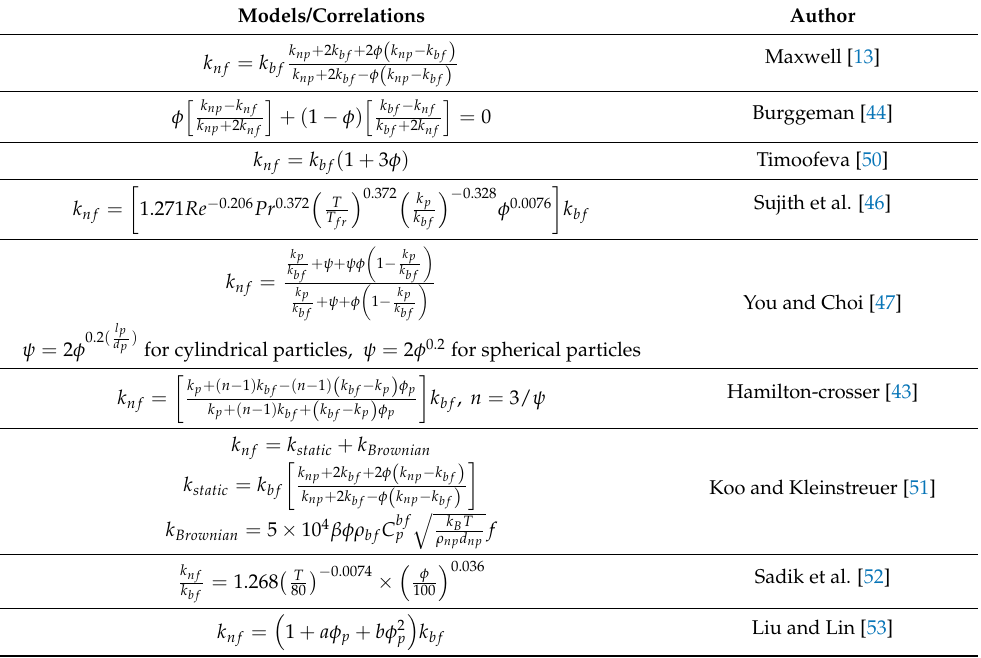
Table 2. Thermal conductivity estimation of metal oxide-based nanofluids (model and correlations).